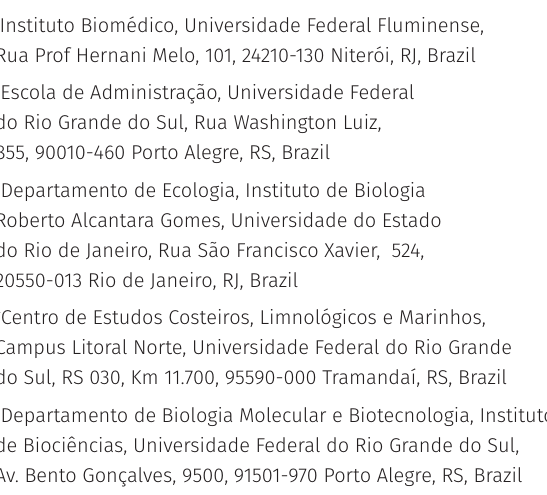
Figure S1. Representation of Brazilian researchers in the ranks by field and gender. Number of Brazilian Scientists in each of the scientific fields by gender. Numbers next to the bars indicate the percentage of female scientists. The two fields (Communication & Textual Studies and Visual & Performing Arts) in which there were no Brazilian scientists are not shown. Figure S2. Gender distribution among Brazilian Scientists in the subfields. Data is presented as the number of men and women in each of the subfields. Numbers next to the bars indicate the percentage of female scientists. Subfields in which there were no Brazilian scientists are not